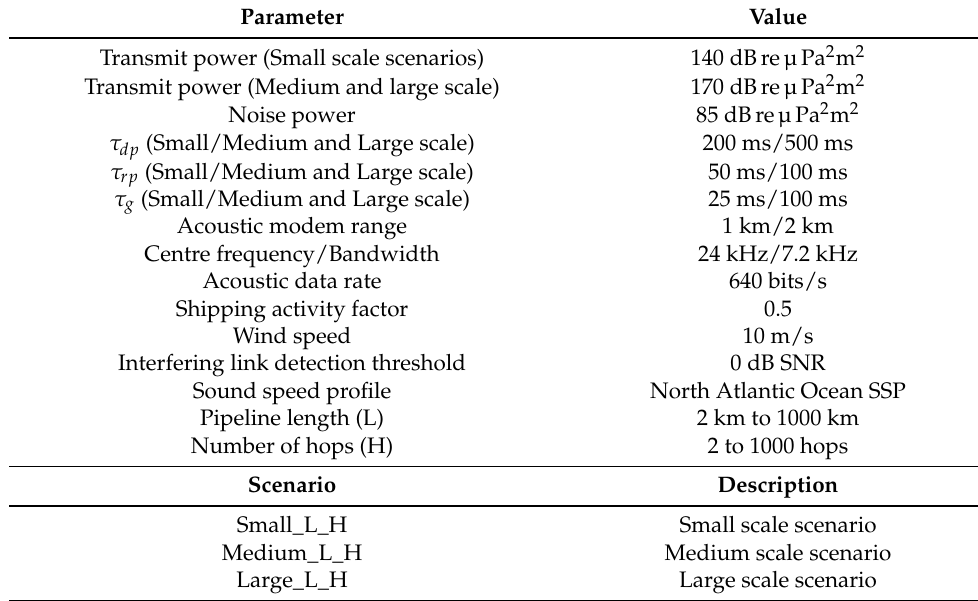
Table 1. Simulation